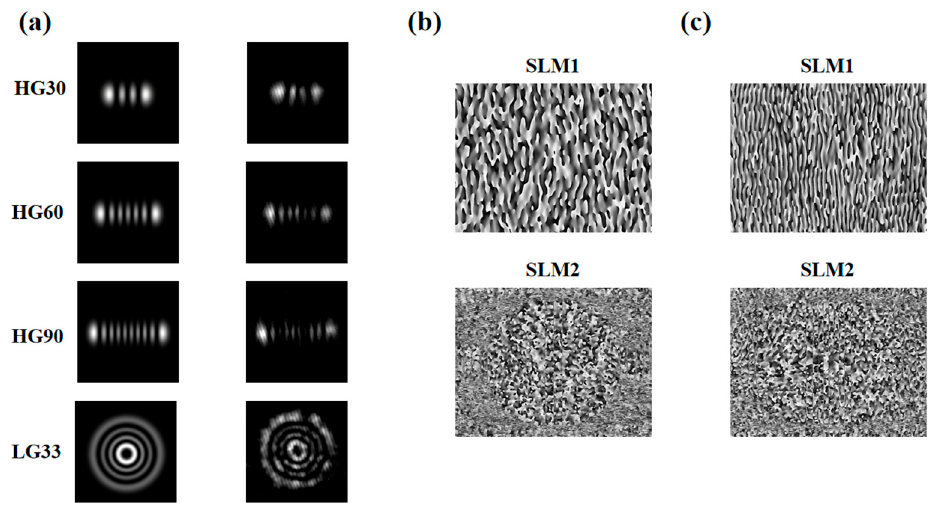
Figure 3. Experimental results for the modes generated. ( a ) The intensity distribution of the HG30 mode, HG60 mode, HG90 mode, and LG33 mode generated. ( b ) Holograms loaded onto the SLM1 and SLM2 to generate the HG30 mode. ( c ) Holograms loaded onto the SLM1 and SLM2 to generate the HG90 mode.